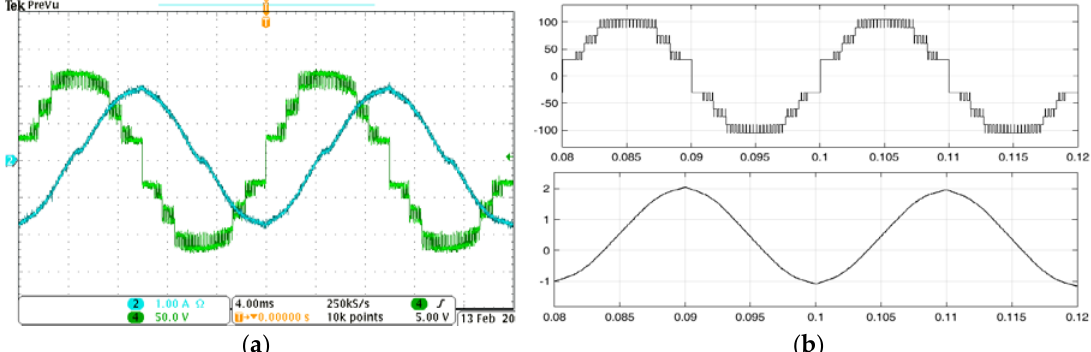
Figure 17. The output voltage (top trace) and current (bottom trace) waveforms with resistive load (50 Ω ) in Mode II without the zero level. ( a ) experimental ( b ) simulation result. Experimental (50 V/div, 1 A/div, 4.00 ms/div).